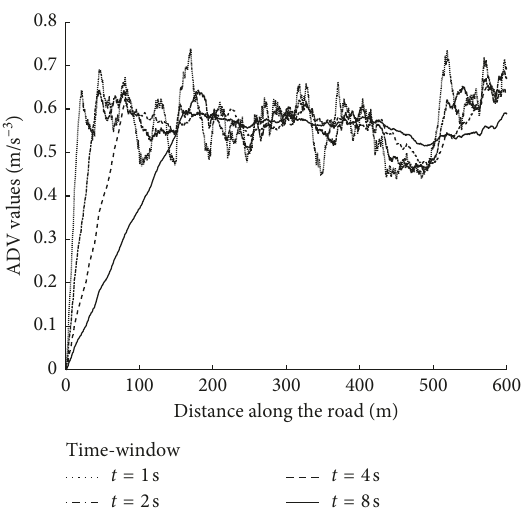
Figure 6: How the mean values and RMS values of ADV change with road roughness at different time-window.